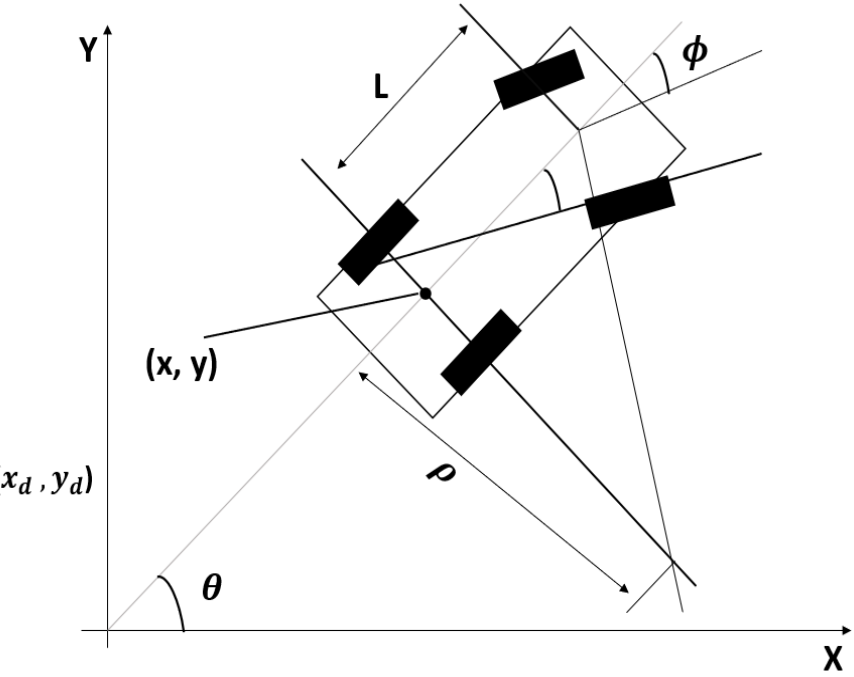
Figure 2. Schematic of the kinematics of car-like four-wheeled vehicles along with their parameters. Several parameters linked with the car-like four-wheeled vehicle are shown in Figure